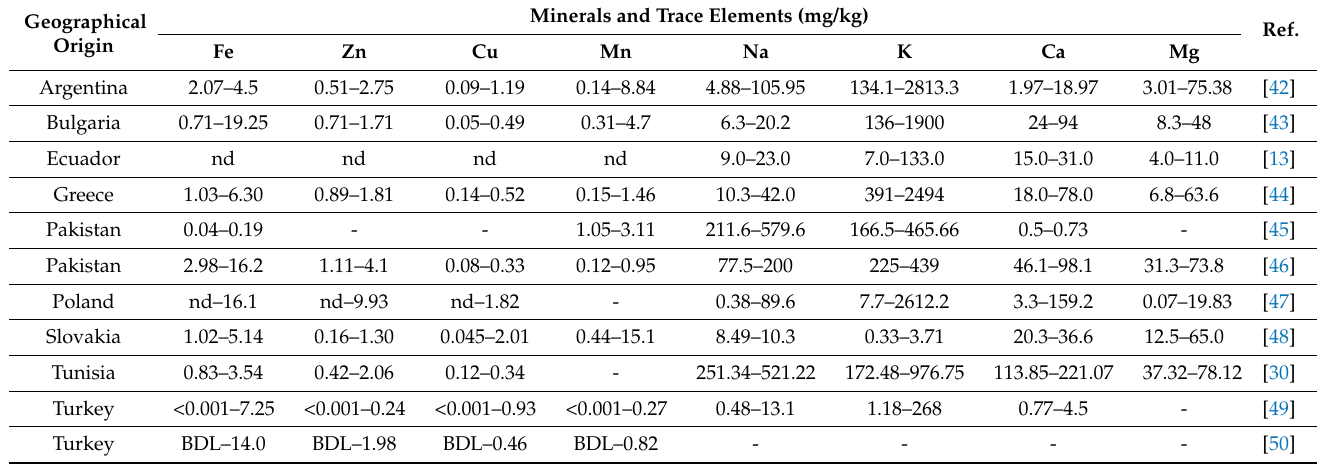
Table 3. Mineral composition and trace elements (mg/kg) of honey from different